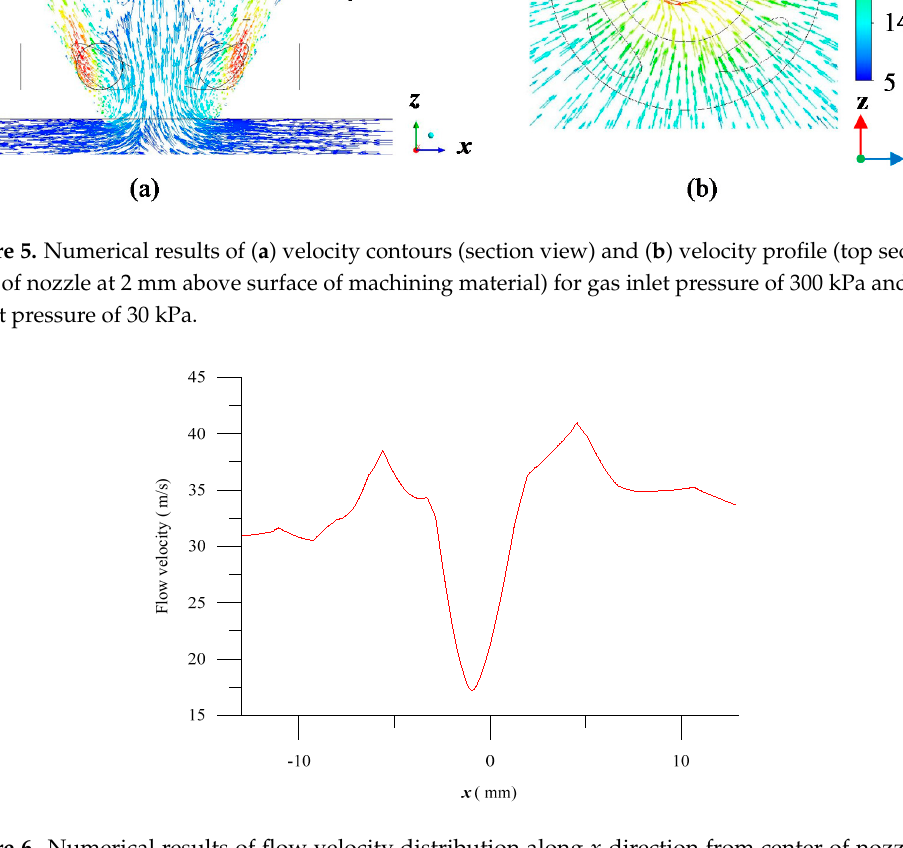
Figure 2. Numerical results of ( a ) pressure contours (section view) and ( b ) pressure profile (top section view of nozzle at 2 mm above surface of machining material) for gas inlet pressure of 300 kPa and gas outlet pressure of 30 kPa. Figure 3. Numerical results of pressure distribution along x -direction from center of nozzle at 2 mm above surface of machining material for gas inlet pressure of 300 kPa and gas outlet pressure of 30 kPa.